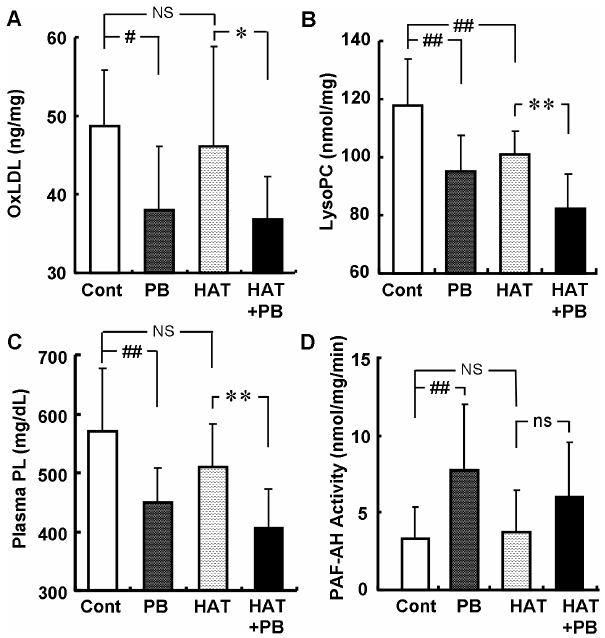
Figure 4. Anti-oxidative Effects of probucol and atorvastatin on plasma lipids. Effects on OxPC (A) and LysoPC (B) contents in LDL, plasma phospholipids concentration (C) and PAF-AH activity in LDL (D) at 6 weeks after administration. Data are presented as mean 6 SD. There were 10 or 11 animals in the control (Cont) and 0.1% probucol (PB) groups, and 12 in the 0.003% atorvastatin (HAT) and HAT + PB groups. *p , 0.05; **p , 0.01; ns, not significant by unpaired t-test. # p , 0.05; ## p , 0.01; NS, not significant by Dunnett’s test. and 0.001% atorvastatin + 0.1% probucol group were excluded